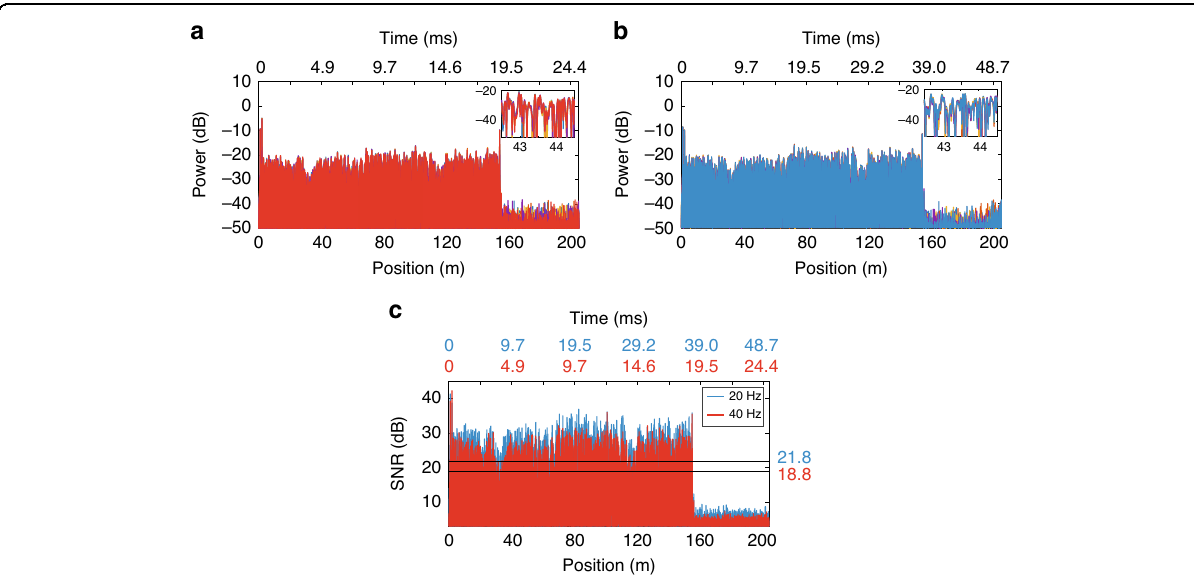
Fig. 2 Illustration of the time expansion. Magnitude of the traces detected using a a 40-Hz offset and b a 20-Hz offset. Insets show the details of several consecutive acquired traces, showing good repeatability. c SNR comparison of both measurements, showing a 3dB average increase for the smaller offset, as expected from the reduced acquisition bandwidth. These results show that the proposed method can expand the temporal duration of the trace, leading to a proportional increase in the SNR but with a loss in the maximum measurable acoustic